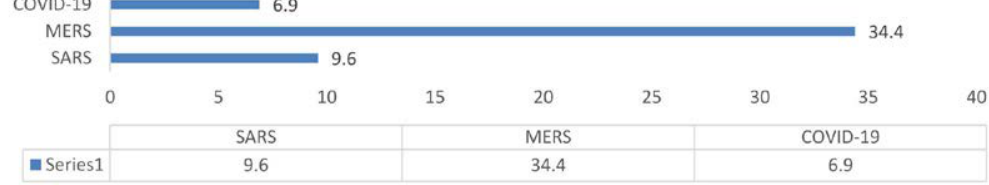
Fig. 1. Mortality rate of SARS, MERS and COVID-19 (as April 24,